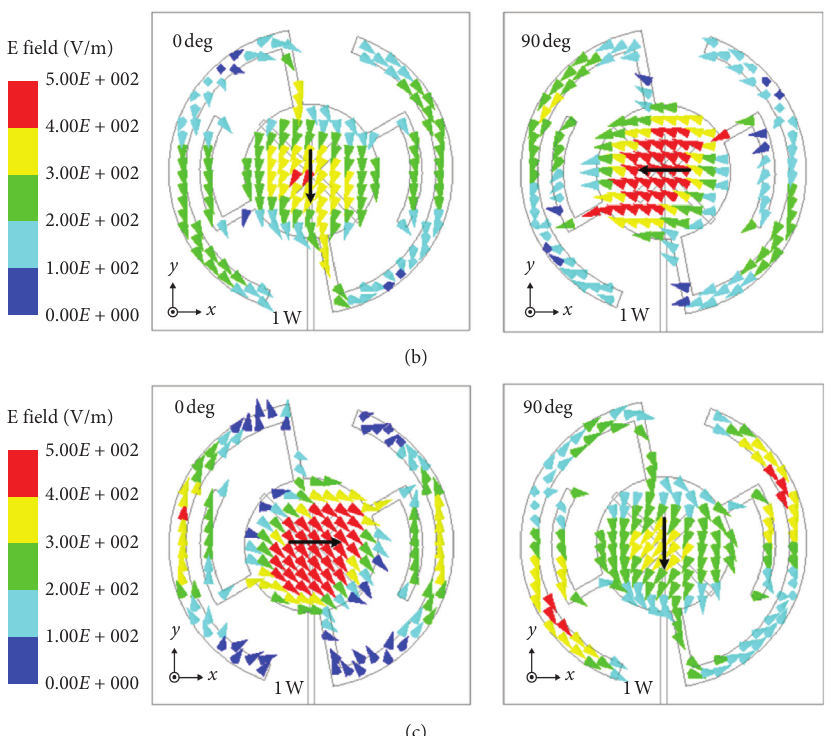
Figure 4: Simulated vector electric field distributions on the upper surface of DR with different phases of 0 ° and 90 ° at (a) 2.18GHz, (b) 2.72GHz, and (c) 3.16 GHz,